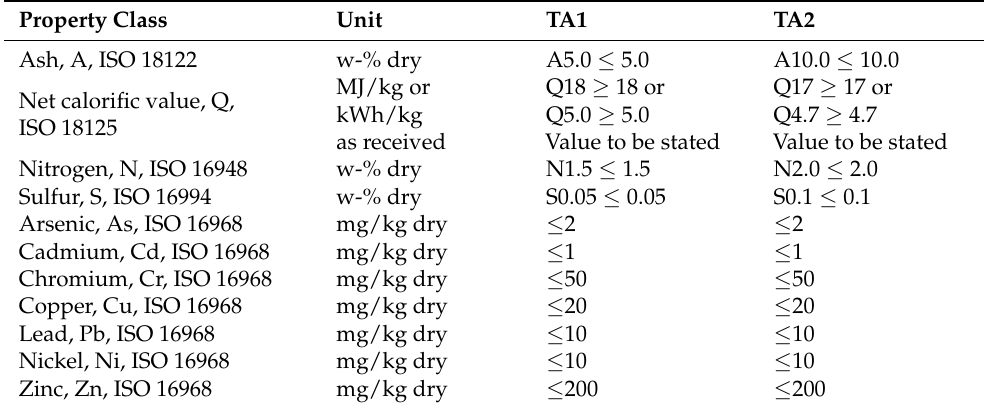
Figure A2. H/C and O/C ratios of the digestate and forest residue for raw and hydrothermally treated solids (generated with a temperature of 130, 150 or 170 °C and with a holding time of 30, 60 or 90 min). Table A1. Specification of graded pellets produced from thermally treated non-woody biomass (DIN EN ISO 17225-8:2016-01).